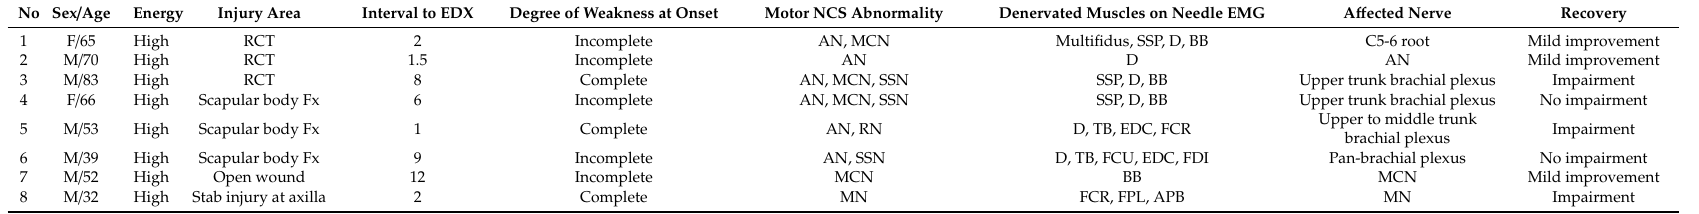
Table 4. Detailed Description of the Peripheral Nerve Injuries in Eight Patients with Other Causes of Shoulder